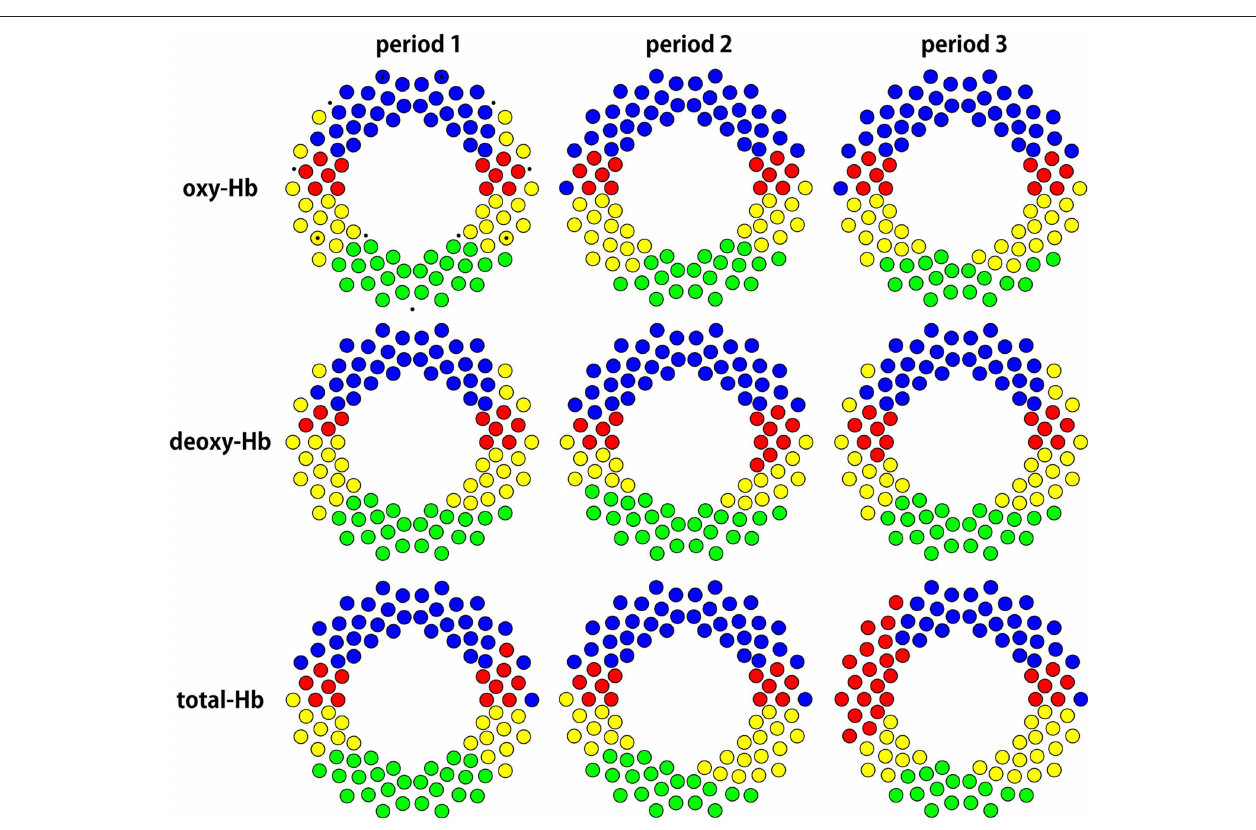
FIguRe 10 | Spatial configuration of the 4 clusters obtained by cluster analyses. We defined the distance between two channels by calculating 1 – r , and conducted cluster analyses. The four clusters in each period can be identified by coloring. The small dots are the landmarks shown in Figure